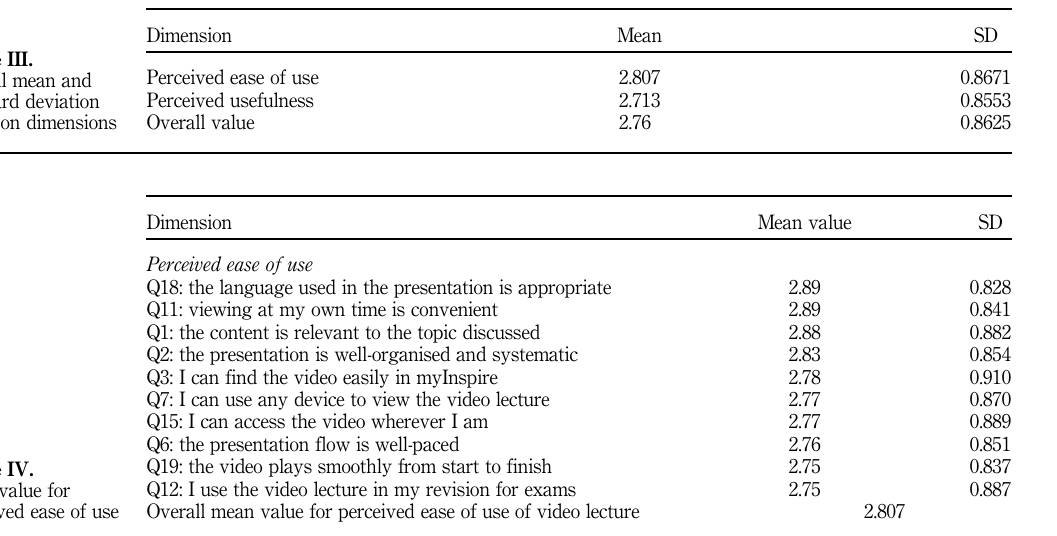
Table IV. Mean value for perceived ease of use